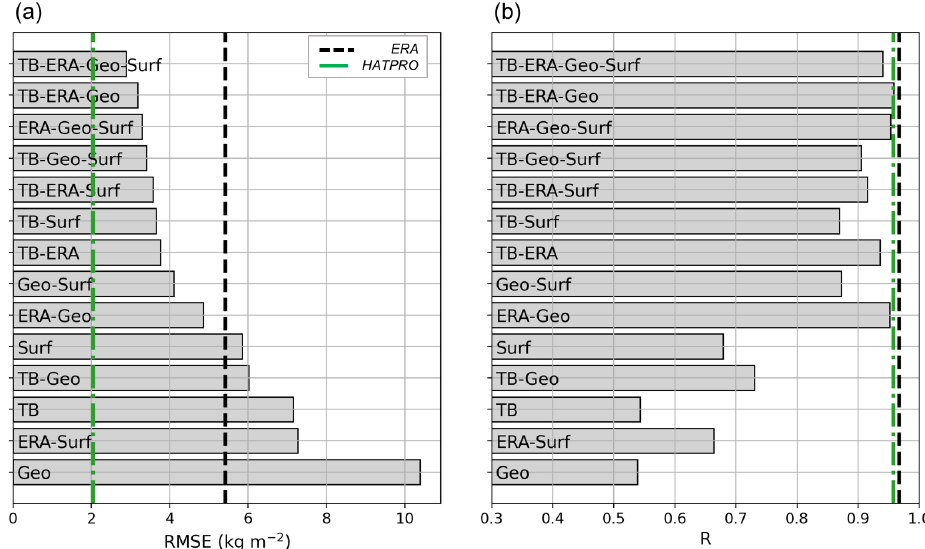
Figure 11. Results of the IWV retrieval in Payerne compared to radiosonde measurements ( a : RMSE, b : R ). The radiometer measurements are averaged over 30min. For comparison, the dashed lines illustrate the error of HATPRO (green) and ERA5 (black) vs. radiosonde-derived IWV.